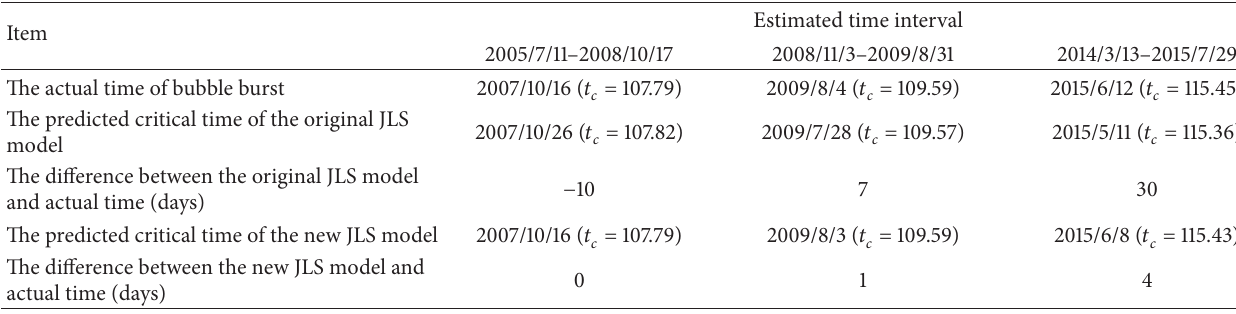
− 10 0 1 4 − 22 2007/11/26 ( 𝑡 𝑐 = 107.90) 2015/6/8 ( 𝑡 𝑐 =